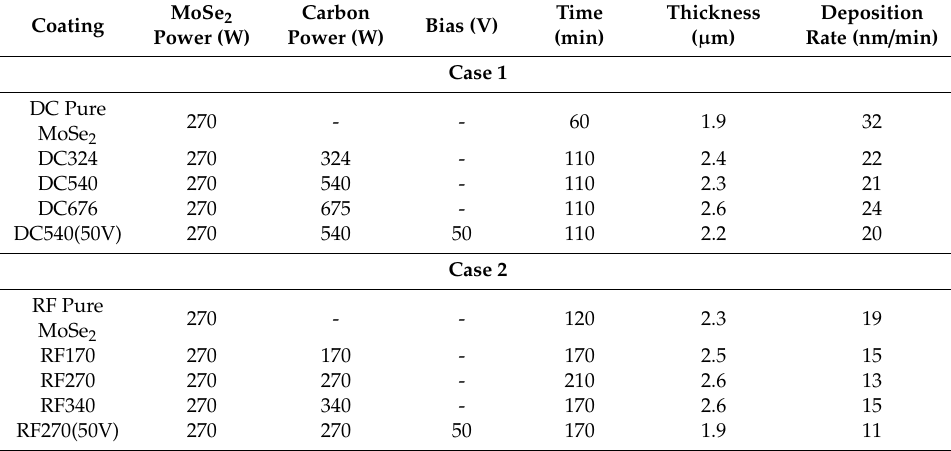
Table 1. Main deposition parameters, thickness and deposition rates of the